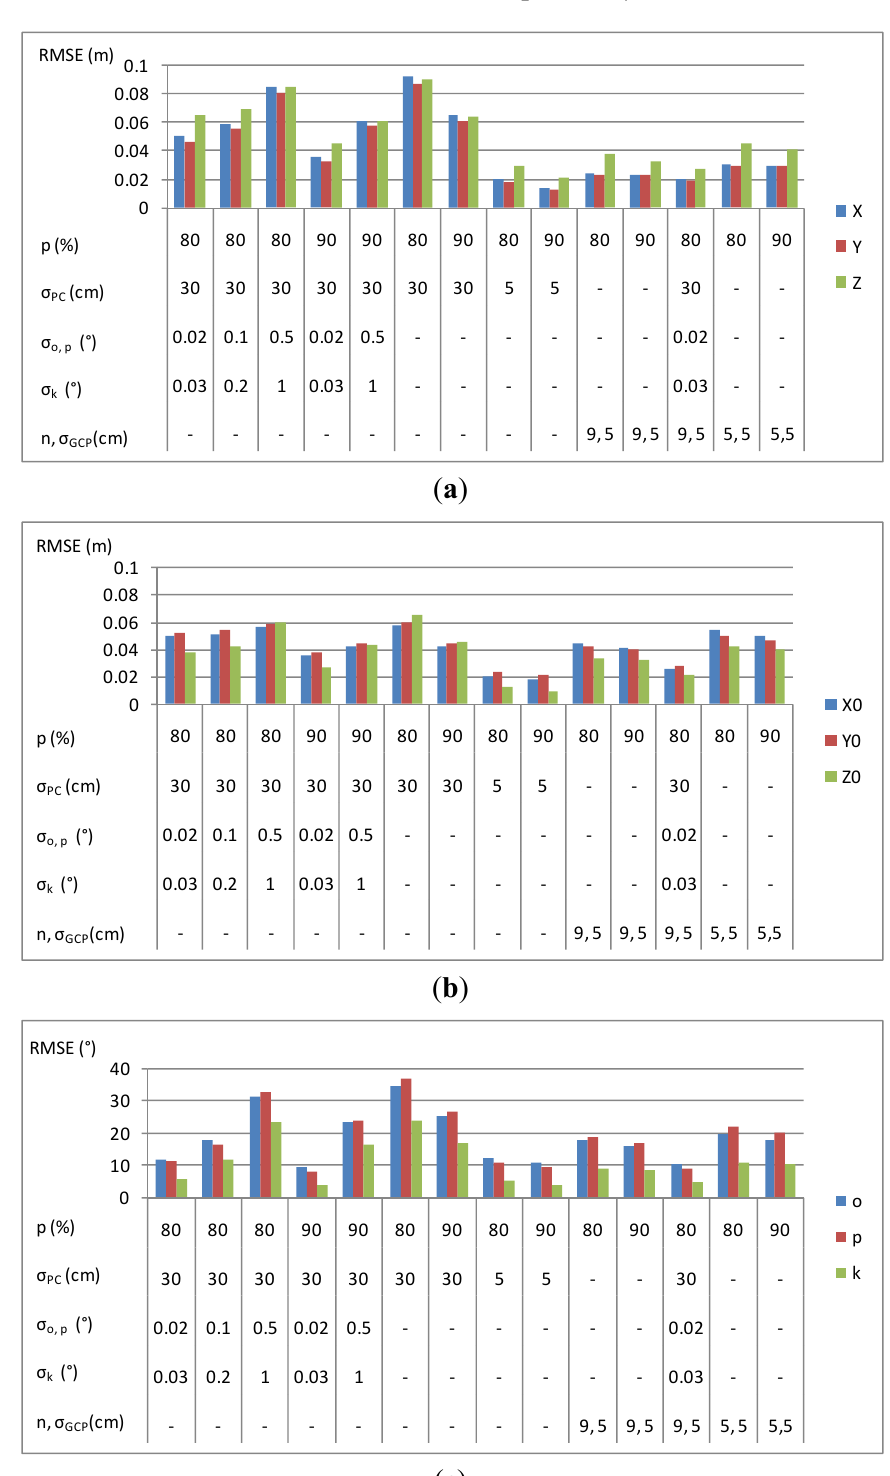
, σ , σ , σ : PC o,p k GCP